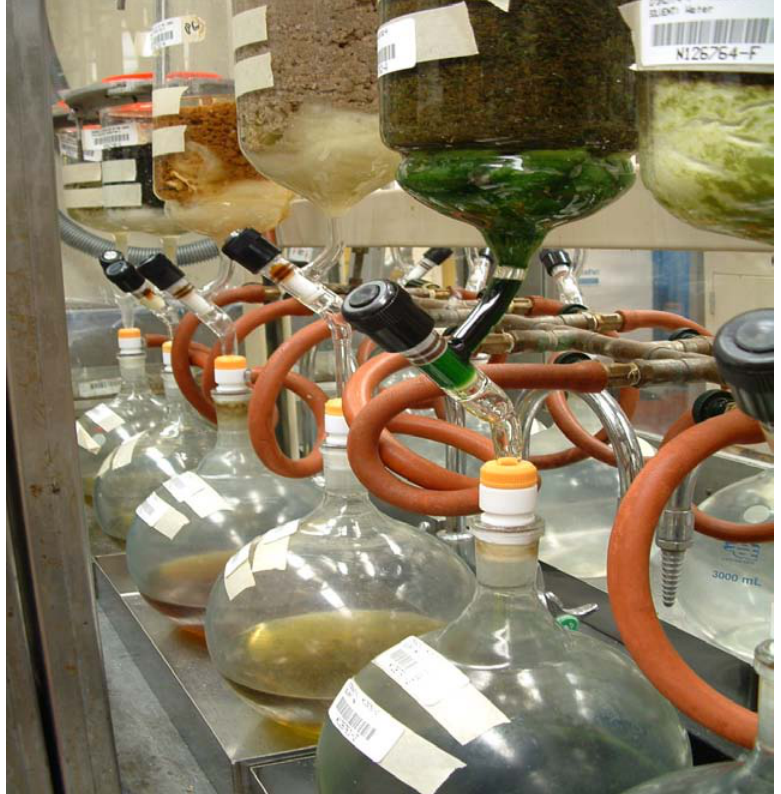
Figure 6. Percolators in use, illustrating bar-encoded labeling over masking tape, cotton filter plug, high vacuum Teflon petcock, vacuum adapter, and 3 L plastic coated flat bottom receiver